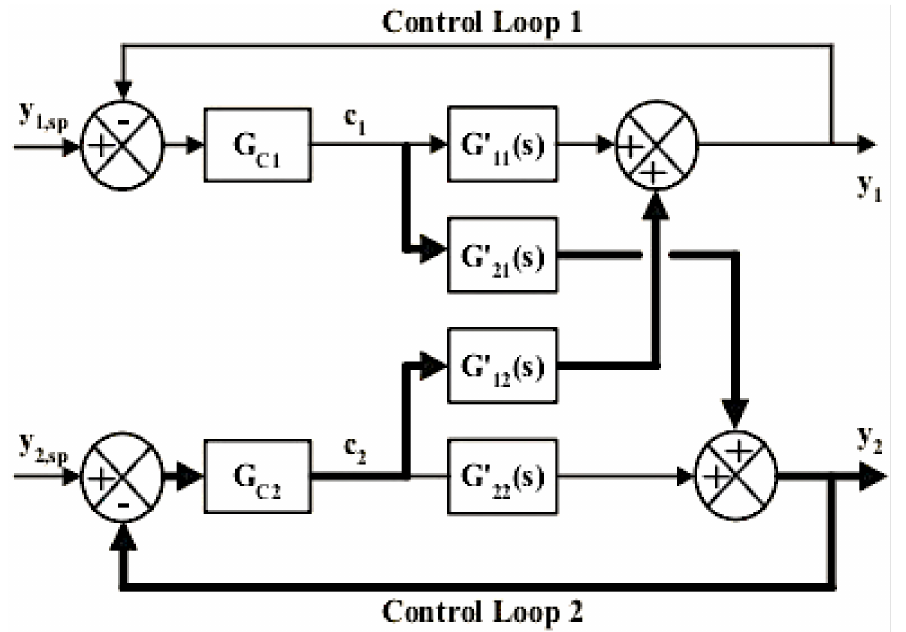
Figure 3. Block diagram of the 2 × 2 MIMO process system multi-loop controller. (Source: Nandong, 2020)